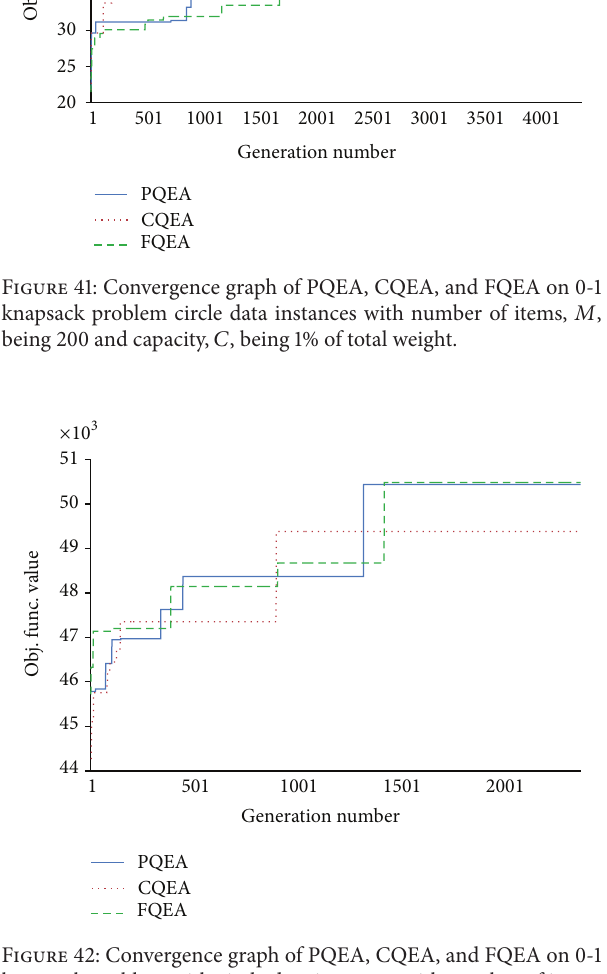
Figure 42: Convergence graph of PQEA, CQEA, and FQEA on 0-1 knapsack problem with circle data instances with number of items, 𝑀 , being 5000 and capacity, 𝐶 , being 1% of total